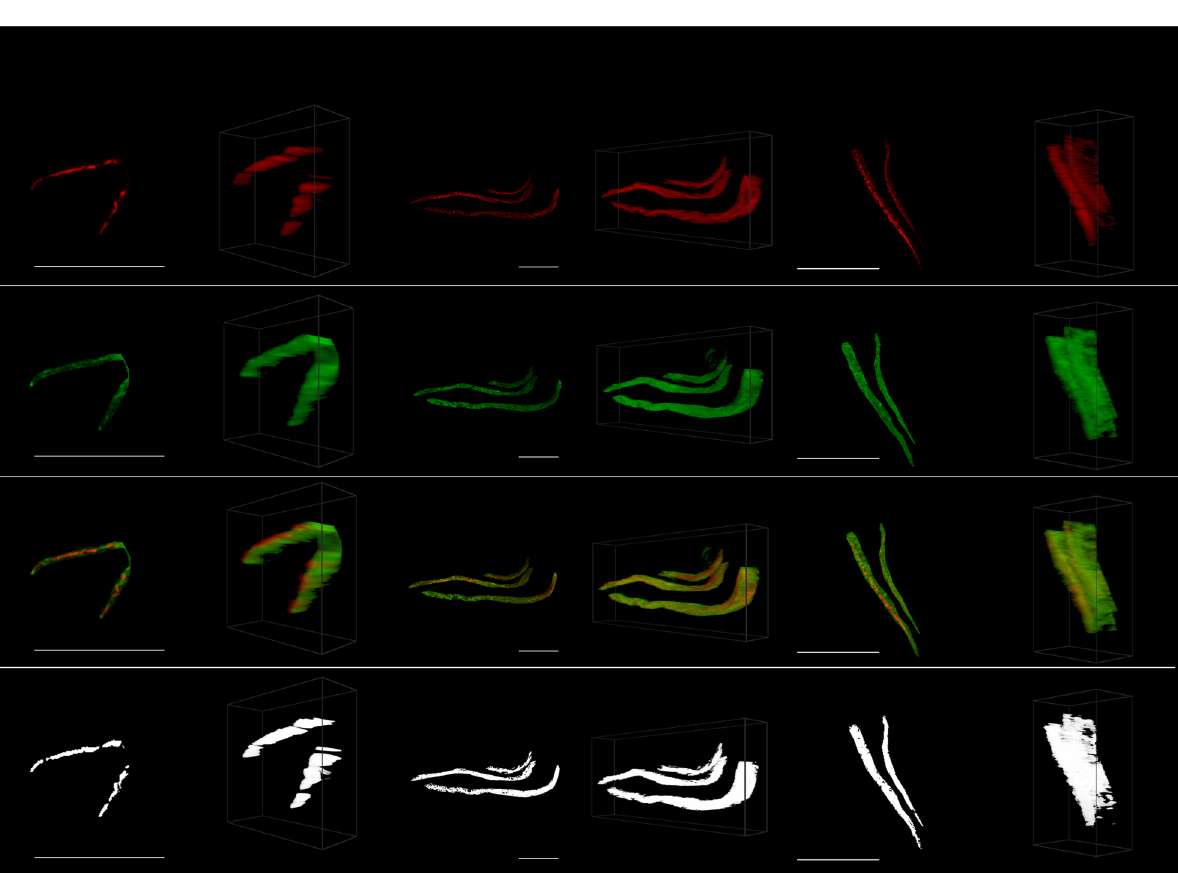
Fig 6. Microtubulin strands. Representative cells for each considered time ( t = 0, t = 6, t = 24) with the maximum intensity projection on the left and the 45˚ 3D view on the right. Shown from top to bottom are the acetylated α -tubulin (red), the Tau (green), the tubulin and Tau overlaid, and only the colocalized